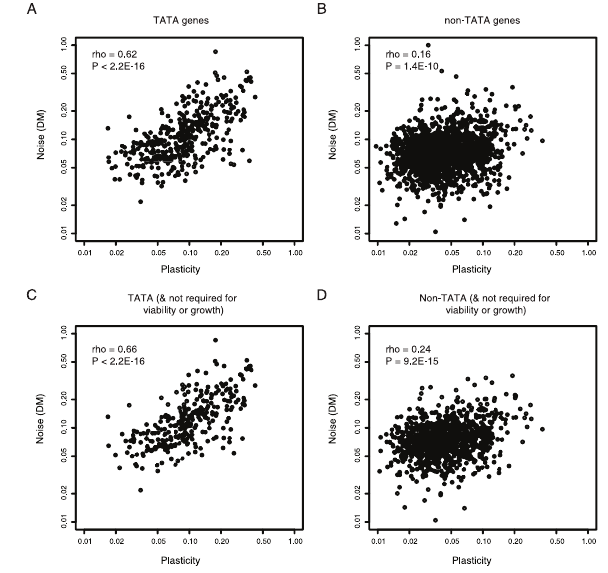
Figure 1. Noise–plasticity coupling relates to promoter archi- tecture. Noise–plasticity coupling for genes initiating from TATA-box promoters (A) and non-TATA promoters (B). Scaled noise and plasticity levels are shown for all genes with available data in yeast. In (C,D) the same comparison is made, but excluding all essential genes, haploinsufficient genes and genes required for growth (C–D). Correlation coefficients and P-values are shown inset.